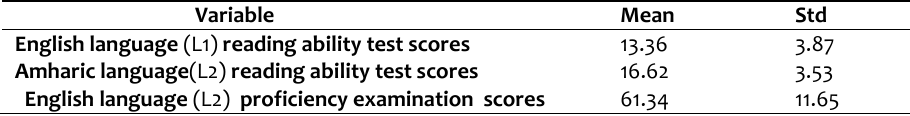
Table 1: Means and standard deviations of (L 1 ) reading ability test, (L2) reading ability test and (L2) proficiency exam scores